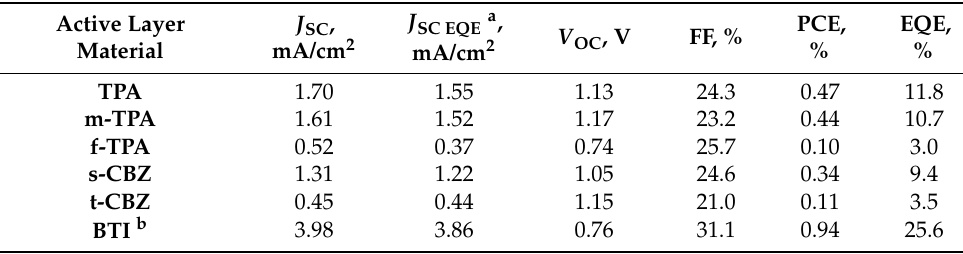
Table 5. The best photovoltaic parameters of SC OSCs under AM1.5G illumination (100 mW/cm 2 ) and maximum EQE